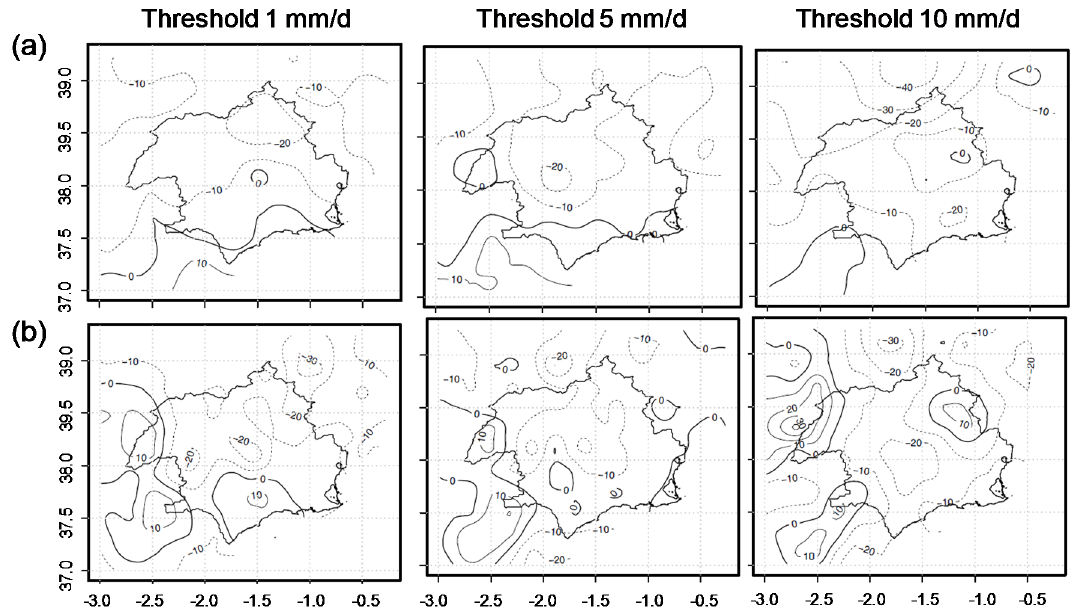
Figure 8. Spatial distributions of differences (Dif %) of σ , for different thresholds: ( a ) Dif (1980–1950)/1950; ( b ) Dif (2007–1980)/1980. Dashed lines represent negatives